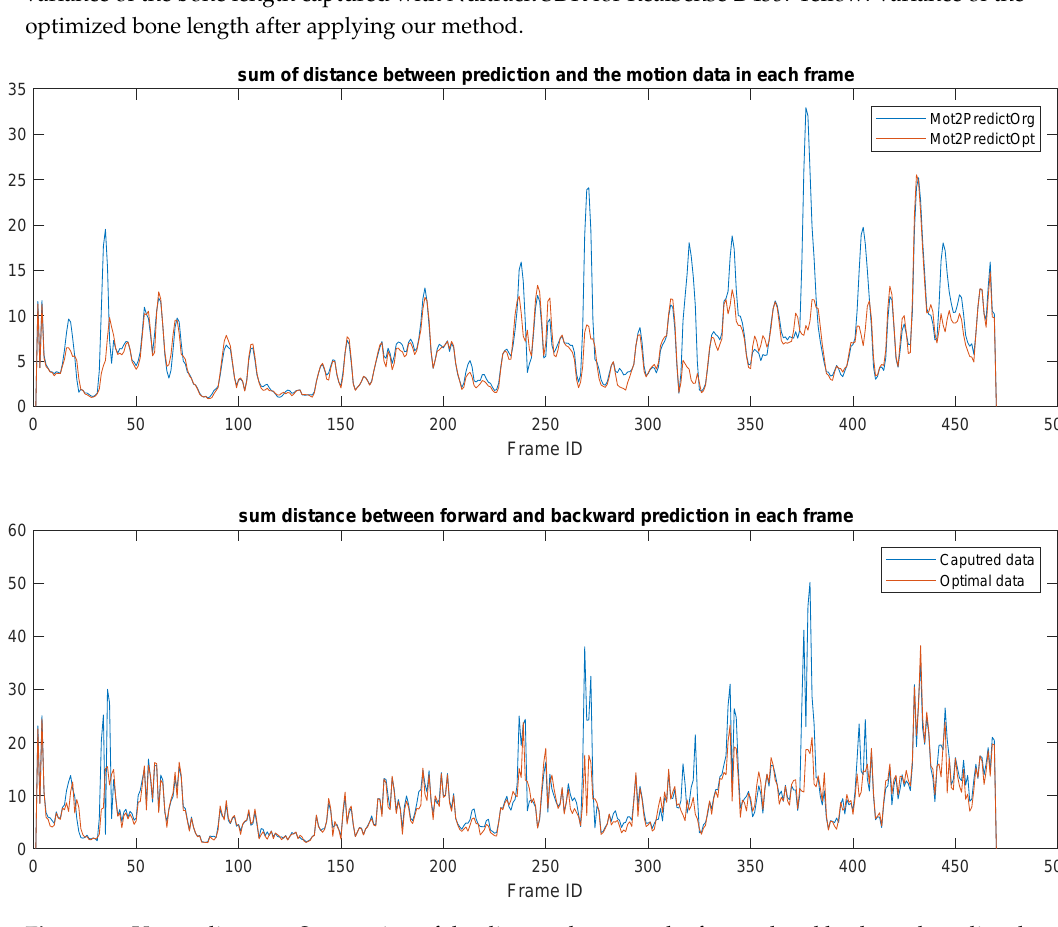
Figure 16. Upper diagram: Summation of the distance between the forward and backward predicted joint positions in each frame. It shows how far the distance is between the estimated joint and the physical predicted position. Bottom diagram: Summation of the distance between joint position and predicted joint position in each frame. It illustrates the temporal symmetry of the motion. Blue: original captured data; Red: motion after